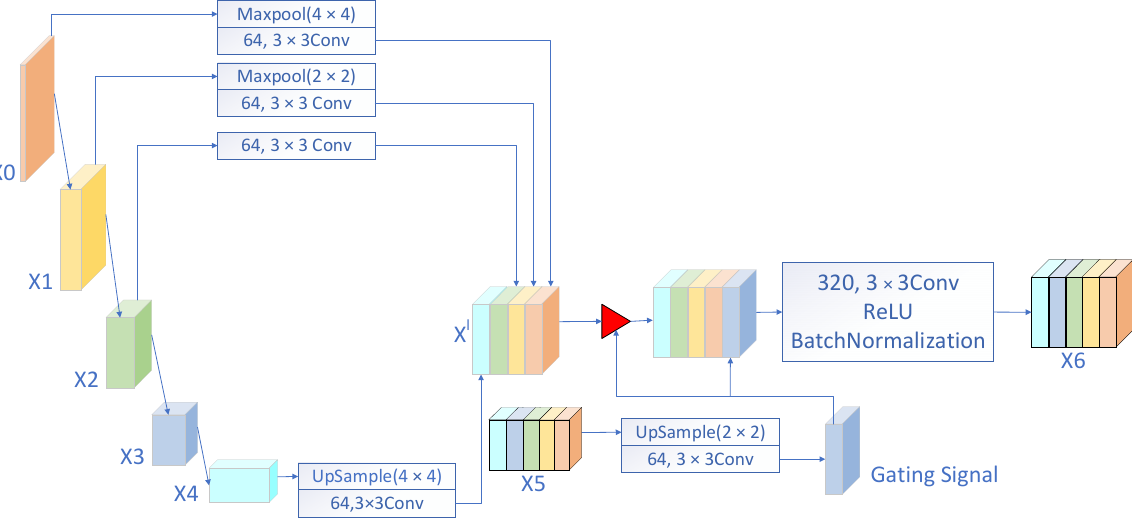
Figure 4. Illustration of how to generate X 6 .